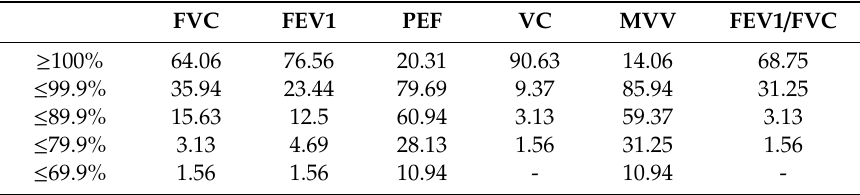
Table 3. Results of pulmonary function test (frequency of probands in PFT % of PV). FVC FEV1